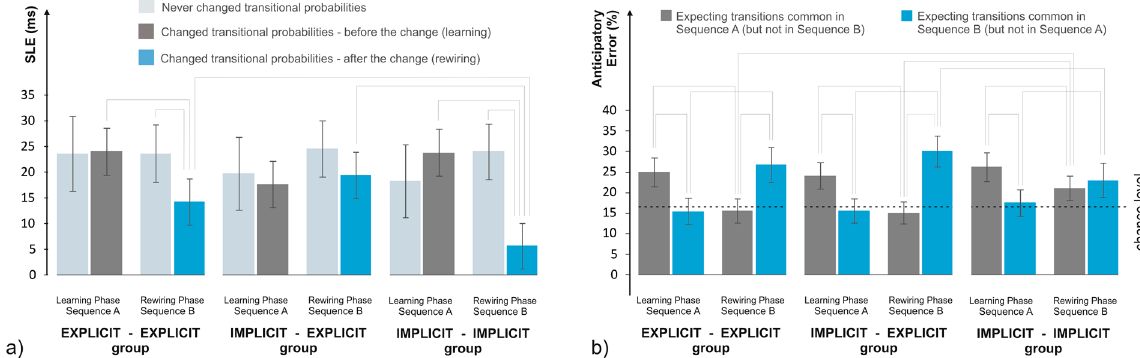
Figure 2. Learning and Rewiring. ( a ) Statistical learning effect (SLE) in the Learning and Rewiring Phase. The magnitude of SLE indicates the difference of reaction times (RTs) given to frequent transitions (more probable stimuli) in contrast to infrequent transitions (less probable stimuli). Some of the transitions had constant frequency in the Learning Phase and Rewiring Phase (unchanged transitions, light grey bars), while other transitions swapped their frequency – previously infrequent transitions became frequent in the Rewiring Phase, and vice versa (changed transitions, dark grey bars – before the change, blue bars – after the change occurred ). Adapting to the changed statistical structure in the Rewiring Phase was shown to be more difficult than learning the contingencies in the first place in the Learning Phase. This was shown by SLEs being – on average – smaller for the changed transitions after the change in frequencies took place in the Rewiring Phase (blue bars) than before the change (dark grey bars). The Implicit-Explicit group did not show signs of such difficulty. ( b ) When a less probable stimulus came up, participants sometimes erroneously pressed the key corresponding to the most probable stimulus, termed as anticipatory errors. As two (partly) different sequences were taught, we differentiated between anticipations of Sequence A’s most probable stimuli, and that of Sequence B’s. Percentage of anticipatory errors of Sequence A (learned in the Learning Phase, grey bars) and Sequence B (learned in the Rewiring Phase, blue bars) over the two Phases, and chance level for anticipatory errors (dotted line) are shown. Each group showed adaptation to the current sequence, as anticipations for Sequence A were above chance level in the Learning Phase, while anticipations of Sequence B were above chance level in the Rewiring Phase. The Implicit-Implicit group additionaly showed above chance level anticipations of Sequence A during the Rewiring Phase, indicating the continuing influence of their knowledge gained in the Learning Phase. The solid lines connecting the bars indicate significant differences ( p < 0.05). Error bars represent 95% confidence intervals